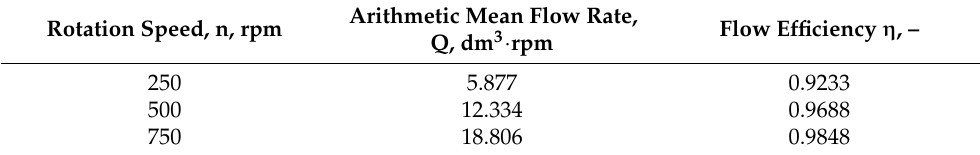
Table 14. Recorded values of the hydrostatic transducer flow during the